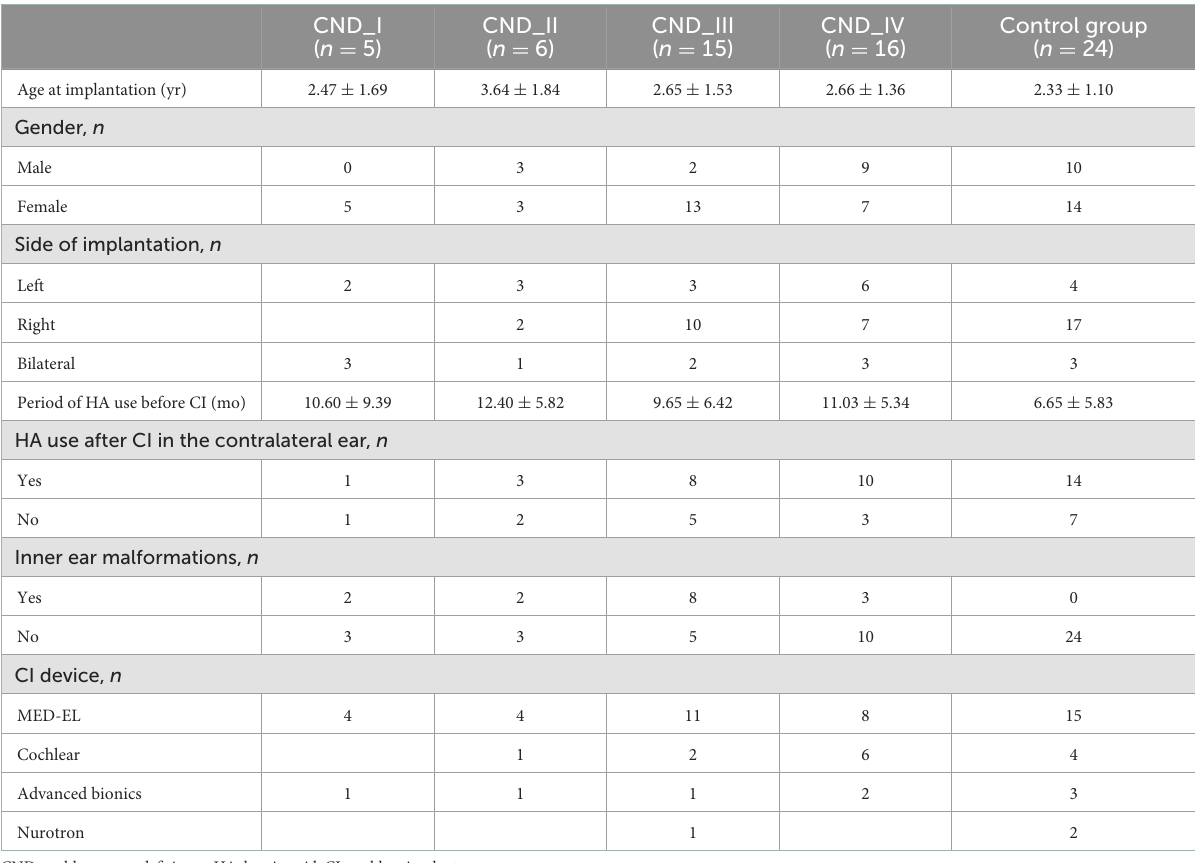
TABLE 1 Clinical characteristics of CND groups and control